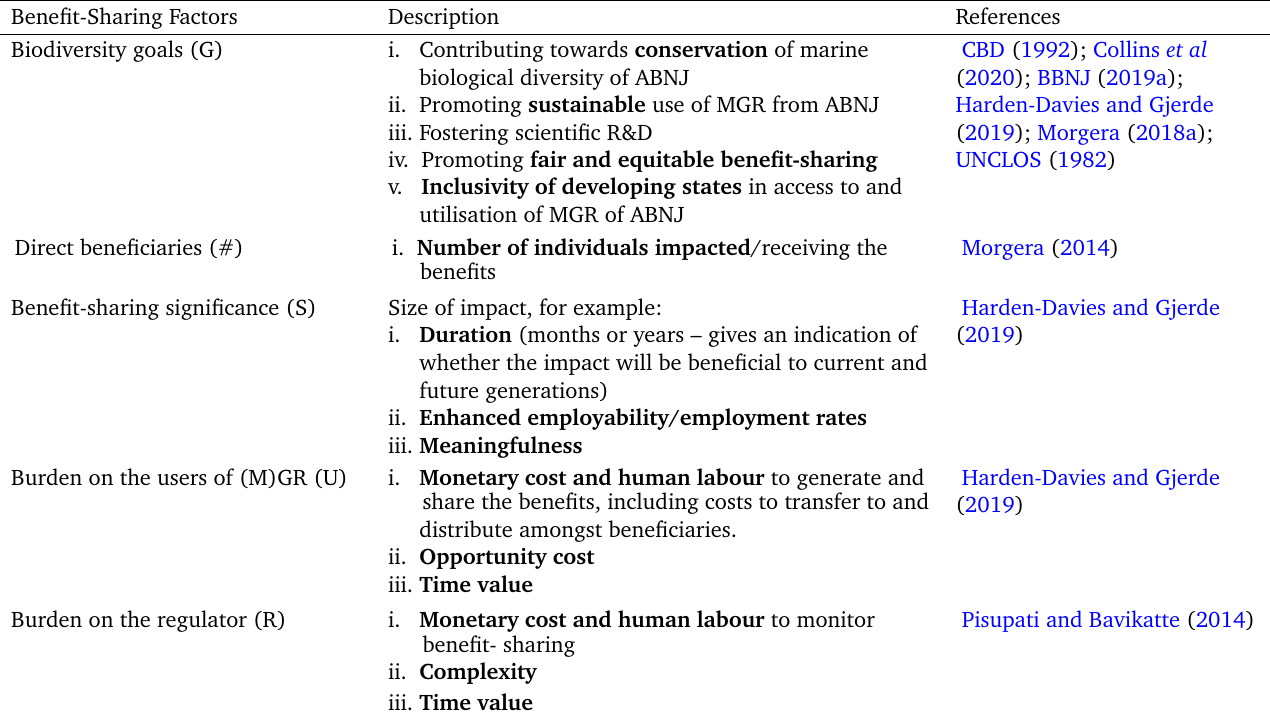
Table 1. Description of the five benefit-sharing factors considered in this study.